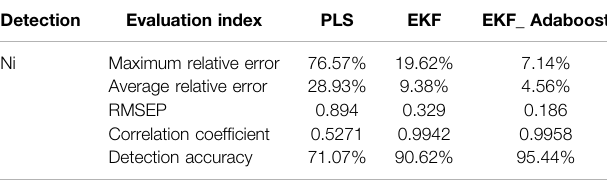
TABLE 2 | Comparison of PLS, EKF and EKF_ Adaboost models. Detection Evaluation